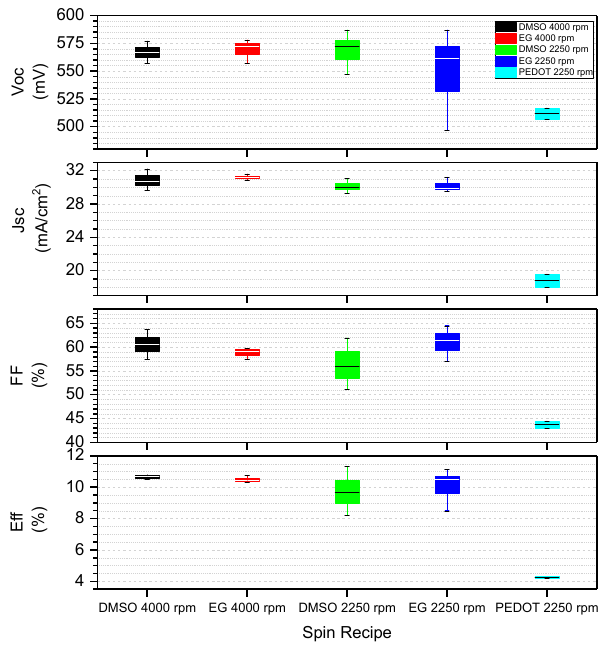
Figure 6. Reproducibility of device performance for different PEDOT:PSS recipes.